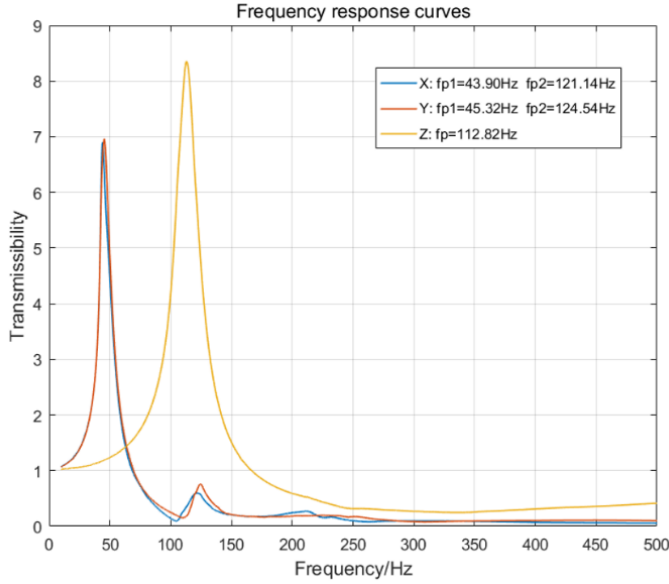
Figure 9. Frequency response test results of Stewart platform.